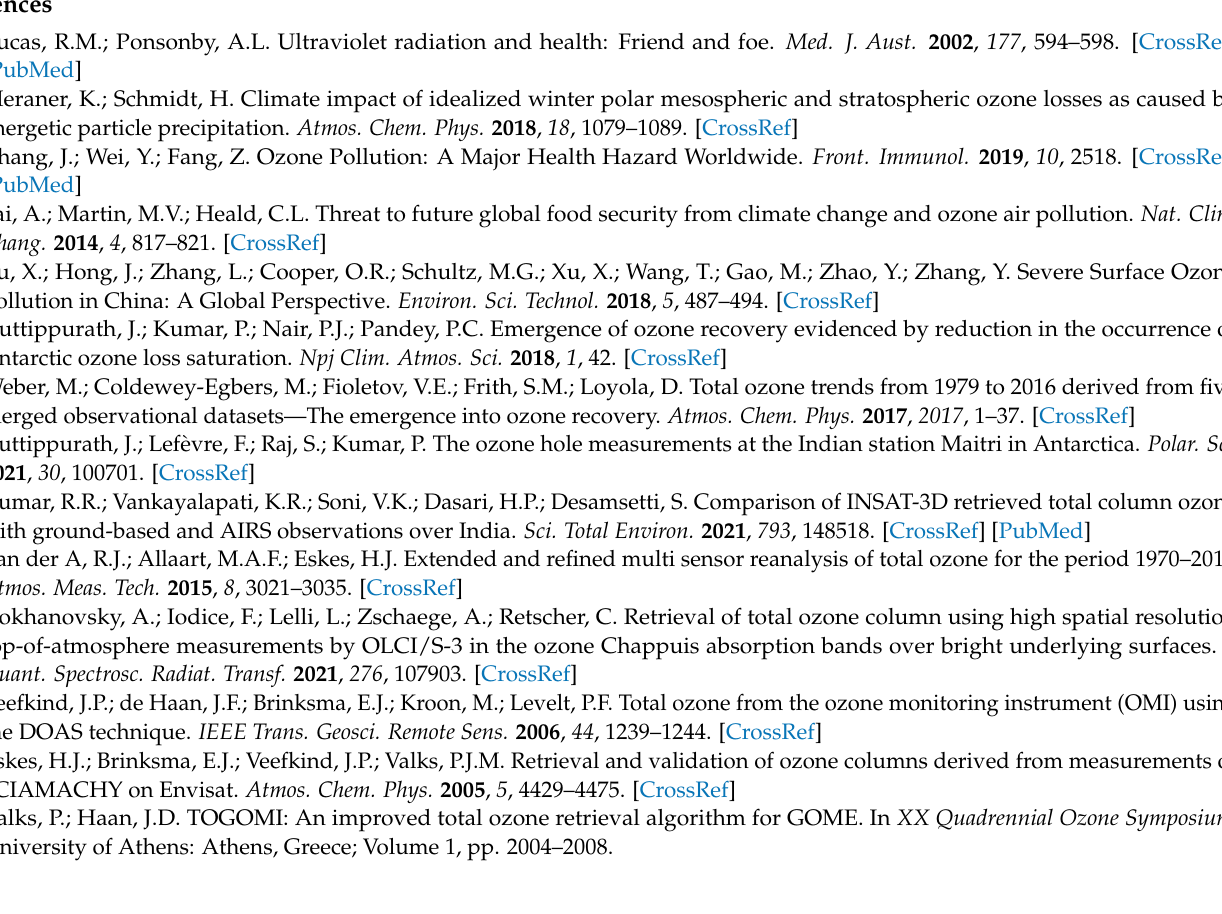
Figure A8. Line graph of the projected monthly change in the TCO results for the Yangtze River Delta Urban Agglomeration in 2020 − 2030. The Red Points Stand for the TCO Prediction Results over the Studied Area in Each Corresponding Year. The Dotted Blue Line is the Fitting Line of the TCO Predicted Results based on the Constructed Fourier Function. The Solid Gray Line is the Linear Fitting Line for the TCO Prediction Results, and its linear Fitting Function is Shown in the Up-right of the Figure.